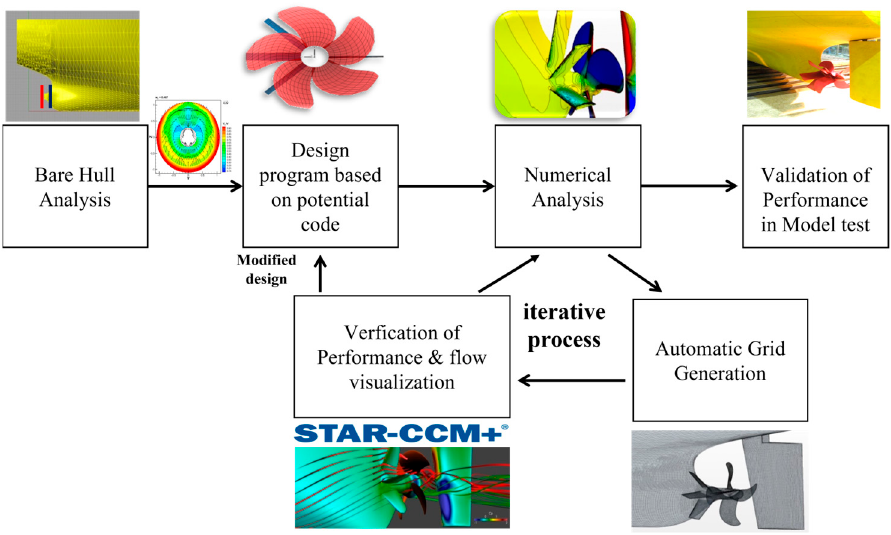
Figure 4. Design process of the PSS.